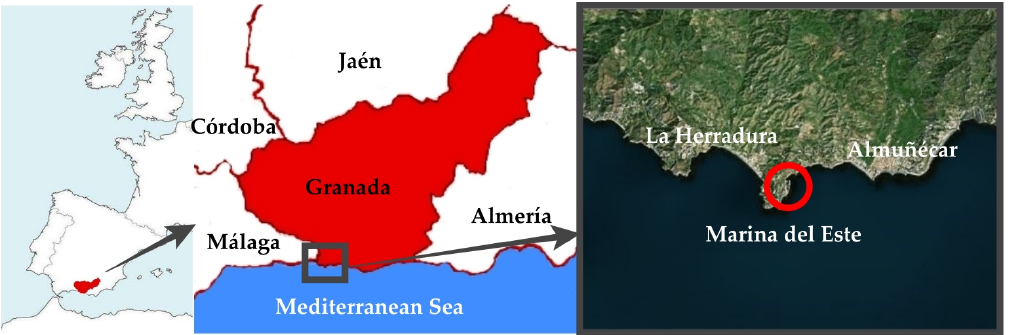
Figure 1. Location of Marina del Este.